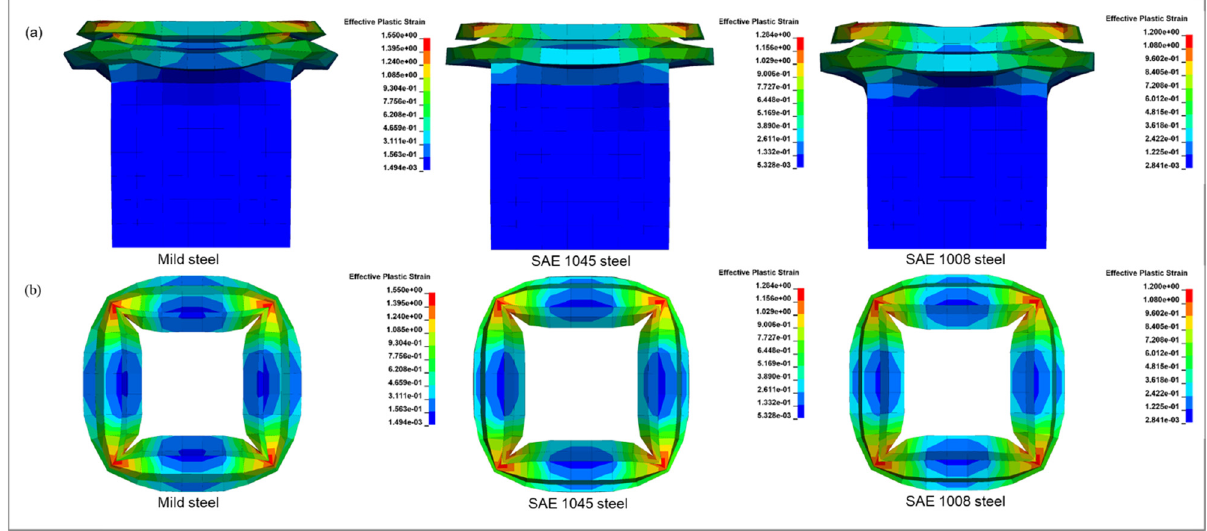
Figure 20: Distribution of the strain on the specimen scaling the time from 0.01 to 1 s. ( a ) Side view and ( b ) top